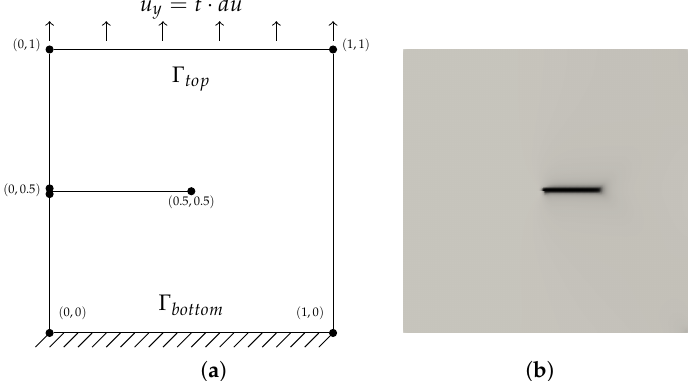
Figure 2. ( a ) Geometry for the single-edge notched tension tests (values given in mm.). A predefined slit is imposed in the geometry of the domain. ( b ) The computed fracture moves on a straight line towards the right boundary.